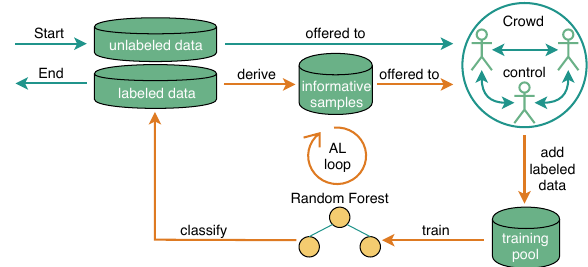
Figure 1. Crowd-based Active Learning